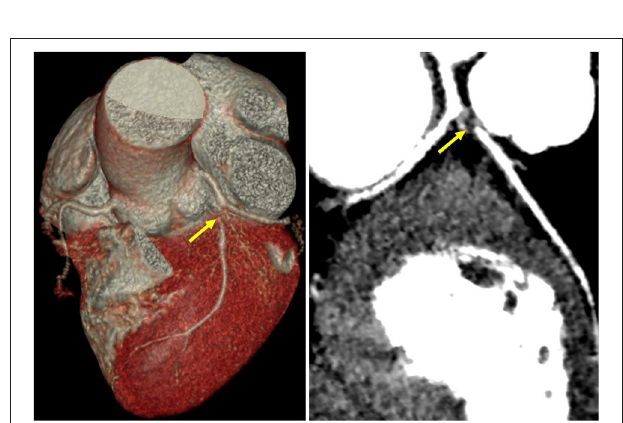
FIGURE 2 | Coronary CT angiography revealed critical stenosis of the left anterior descending artery (yellow